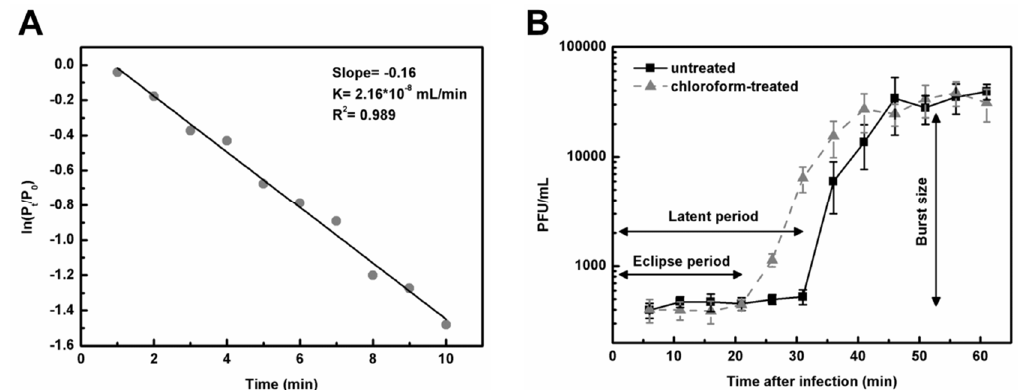
Figure 8. Adsorption rate constant and one-step growth curve of DLc1 using B. cereus 1582-3B as the host. ( A ) The representative linear fitting result of a single adsorption rate constant determination at a MOI added of 0.001; ( B ) One-step growth curve of DLc1 at a MOI added of 0.1. The